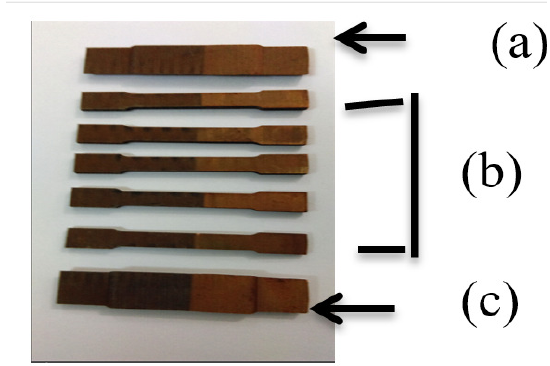
Fig. 2. Specimens for Tensile test.